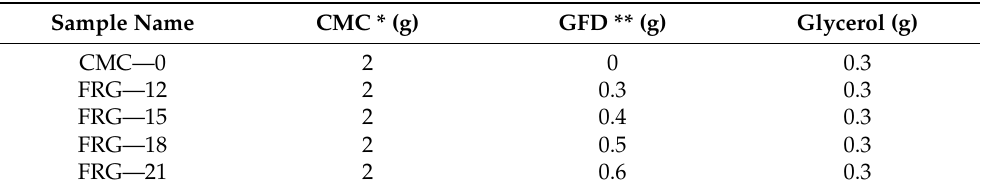
Table 1. The formulation codes, composition, weight ratio of sublingual films based on carboxymethyl cellulose (CMC) (control sample) and sublingual films based on CMC and G. biloba ethanol